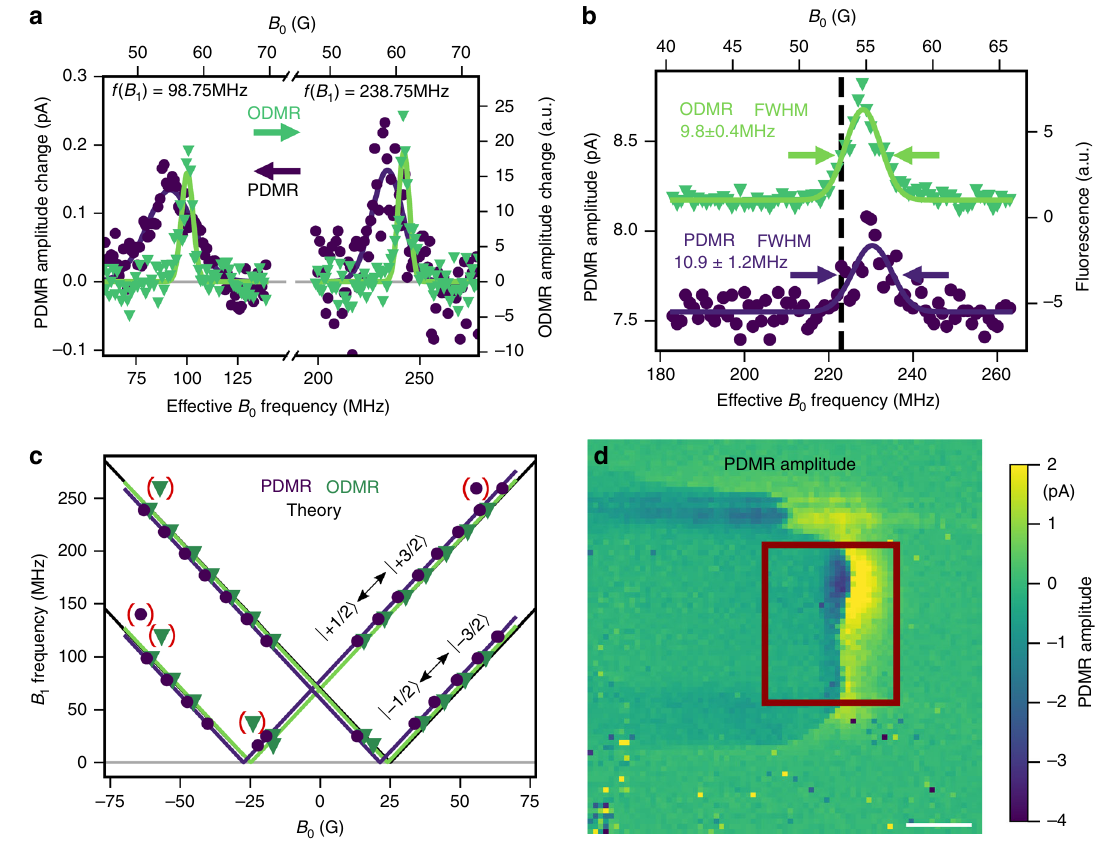
PDMR and ODMR signals of upper and lower transition between ± 1/2 and ± 3/2 spin subsets at Fig. 3 ODMR compared to PDMR. a Comparison of V (cid:1) Si − 10V Bias. Offset removed for comparison. Green triangles indicate ODMR, purple dots PDMR data points. Gaussian fi ts to PDMR are plotted as purple, ODMR as green lines, respectively. b Similar linewidths in ODMR and PDMR measurements at + 20V Bias. The black dashed line indicates the expected resonance frequency. c PDMR and ODMR Zeeman splitting. Green triangles and purple dots mark peak positions from ODMR and PDMR measurements, respectively. Colored lines show a fi t to the data, where data points in brackets are neglected. Black lines show expected theoretical values and are overlapping with measurement results. d PDMR amplitude map over optical excitation position. Estimated device position marked as rectangle. Scale bar: 5 µ m.